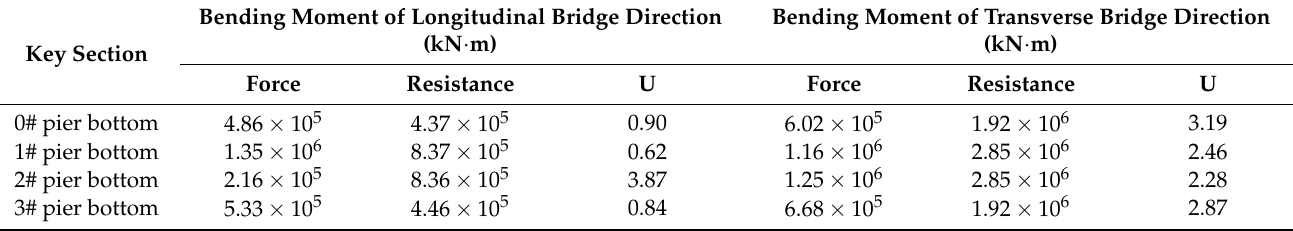
Table 2. Calculation of seismic capacity of pier.